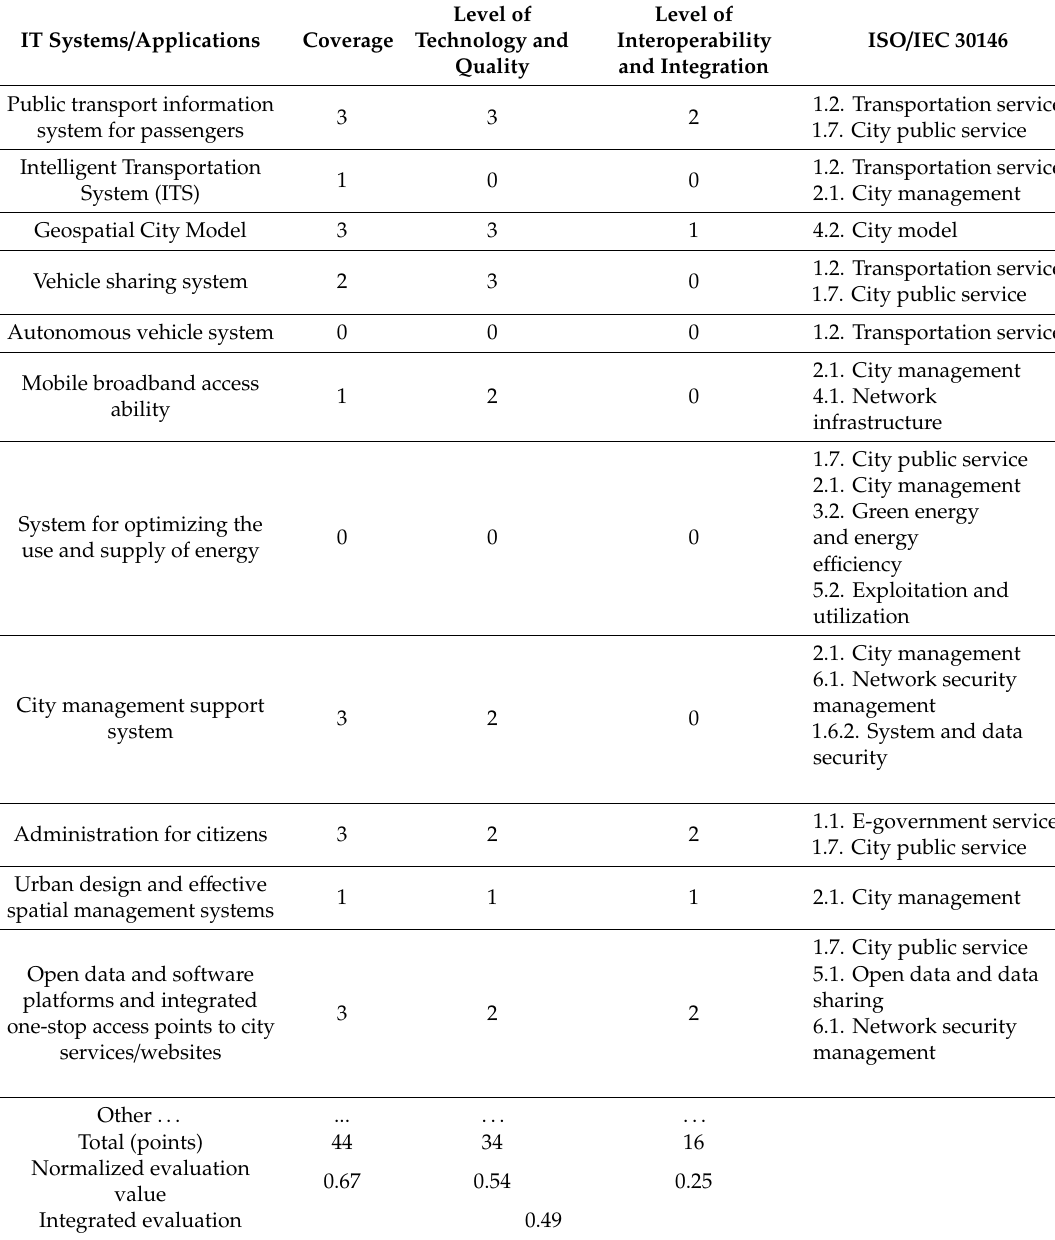
Table 2. Assessment of features of the ICT